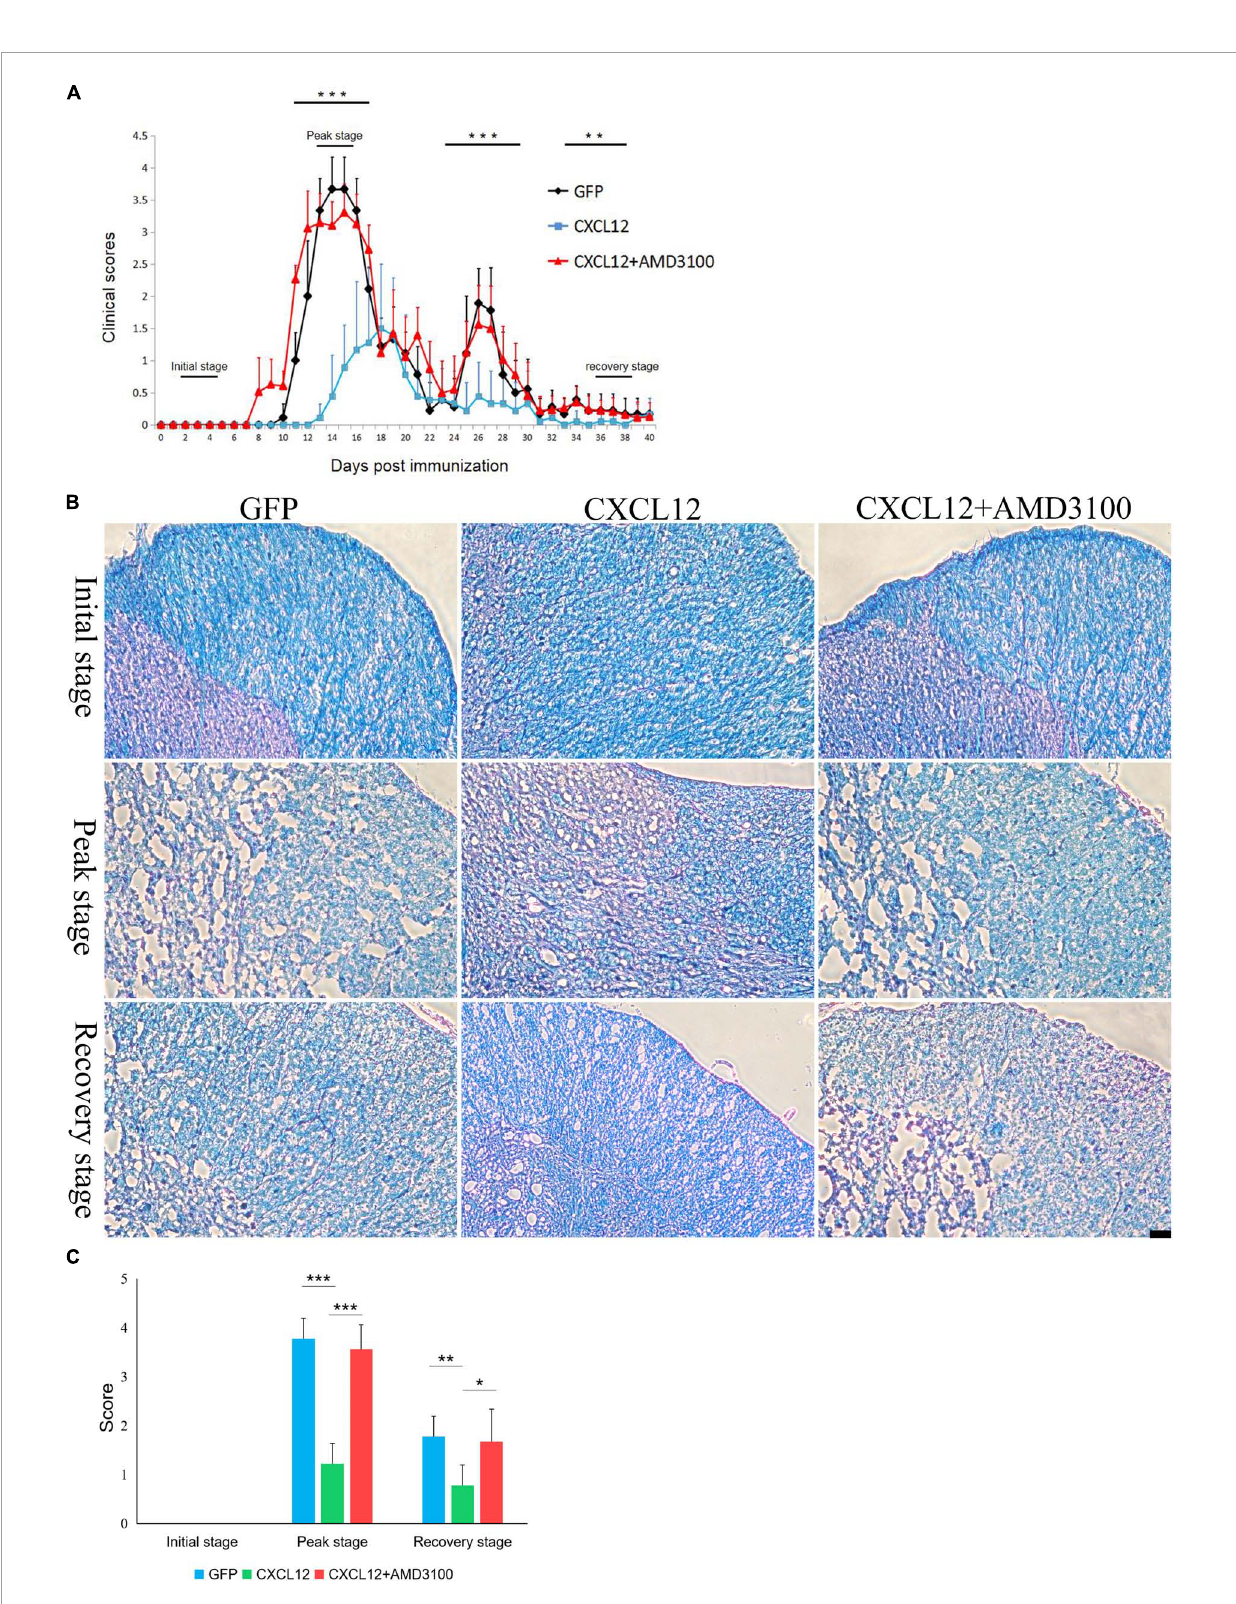
FIGURE2 Upregulation of CXCL12 in the spinal cord can effectively reduce the clinical scores and demyelination of experimental autoimmune encephalomyelitis (EAE). (A) EAE was induced in Lewis rats ( n = 15 in each group). The clinical scores were determined as described in the Methods section. The horizontal bars show the stages of EAE progression (the initial stage was 2–4 days, the peak stage was 12–14 days, and the recovery stage was 38–40 days). The rats were sacrificed for immunofluorescence detection at the each stage. (B) Representative images of Luxol fast blue periodic acid-Schiff (LFB-PAS) staining in the spinal cord at three stages in all three groups. The bar in the lower right represents 50 µ m. (C) Demyelination score based on LFB-PAS staining in spinal cord. Data presented as the mean ± SEM. “*” represents value of P < 0.05, “**” represents value of P < 0.01, “***” represents value of P < 0.001 by 2-tailed unpaired Student’s t -test or 1-way